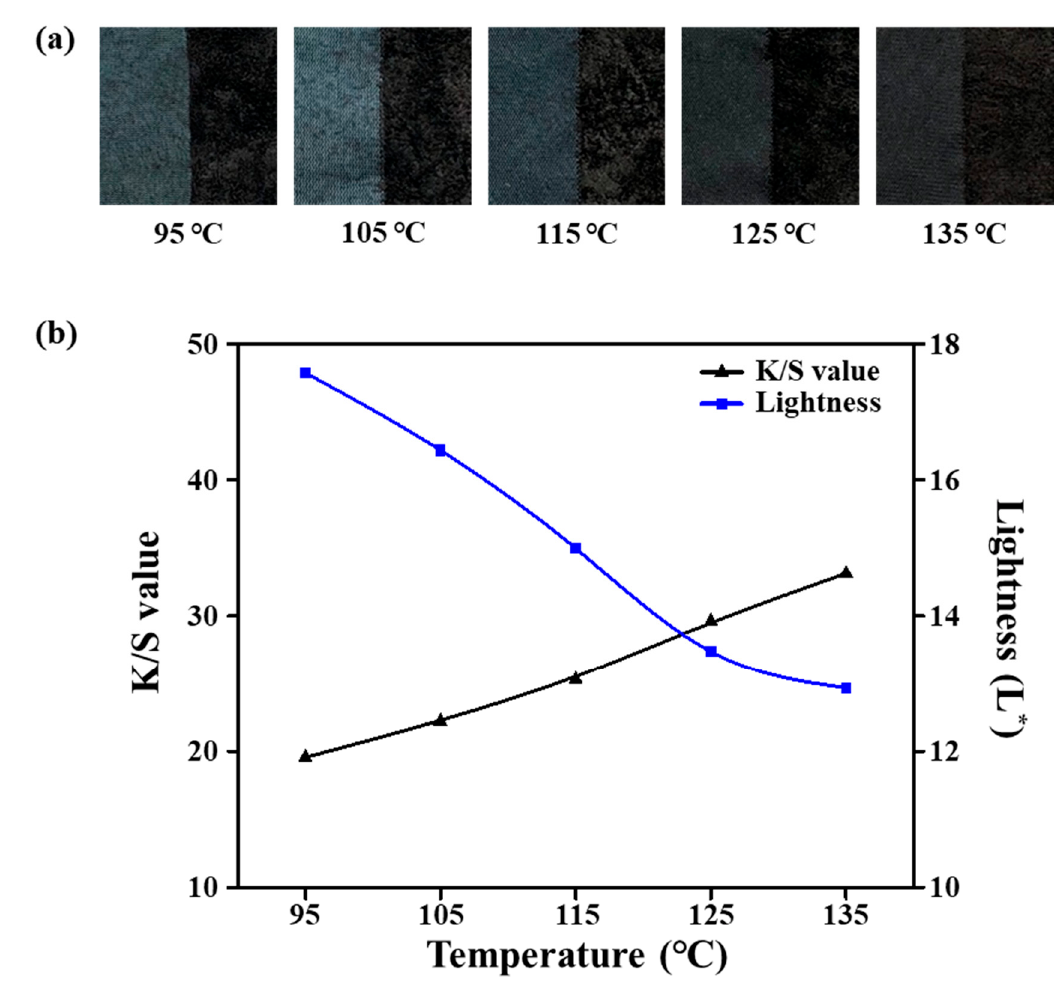
Figure 4. ( a ) Dyed samples. ( b ) K / S and lightness (L*) values according to the dyeing temperature (95–135 °C).